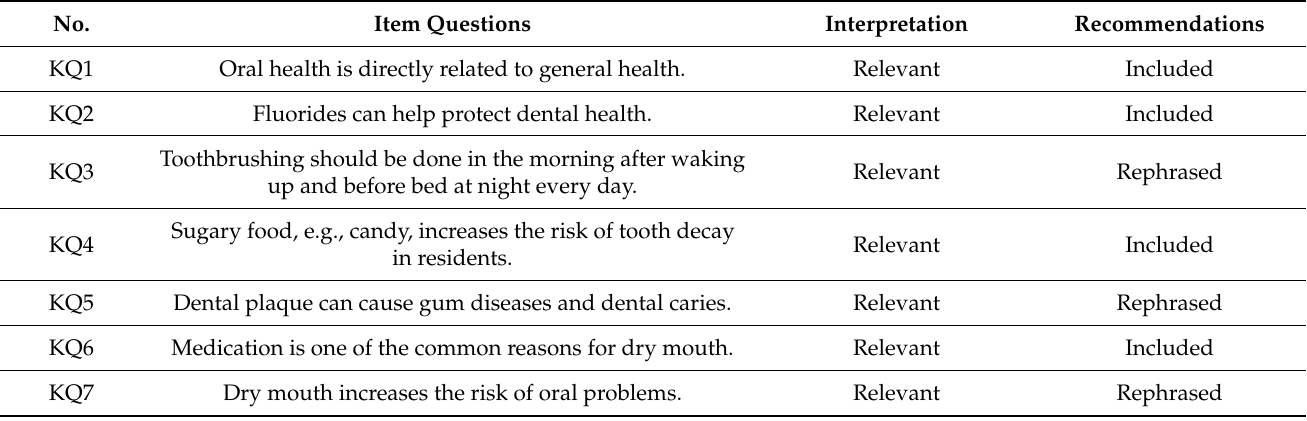
Table 1. Expert review for relevancy check and